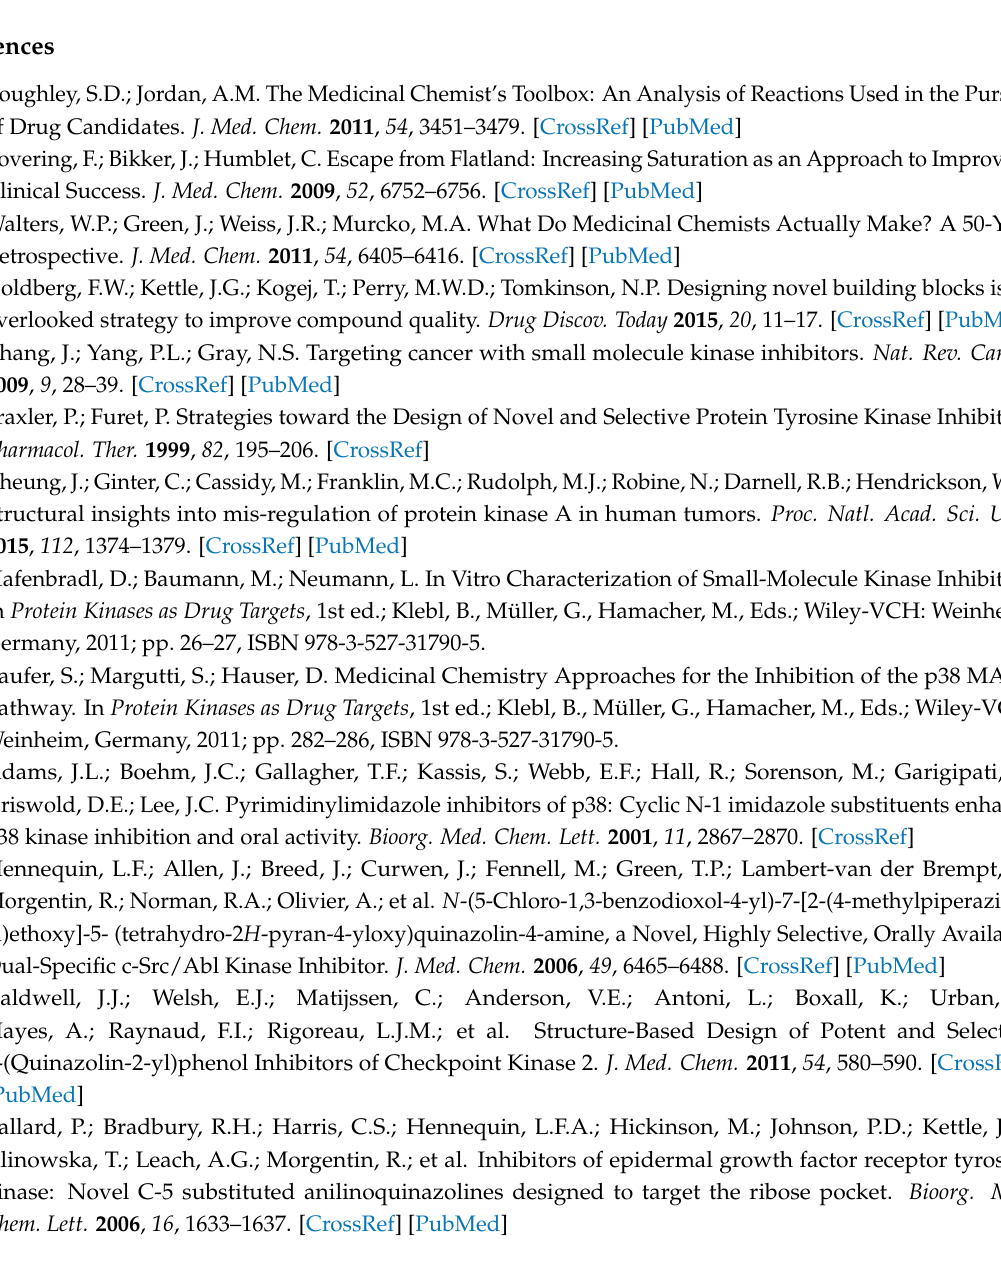
25d Table S1: Data collection, structure refinement and Ramachrandran plot results of protein crystallization, Table S2: Selectivity profile of compound 29d , Appendix: NMR spectra, HPLC chromatograms and DSC